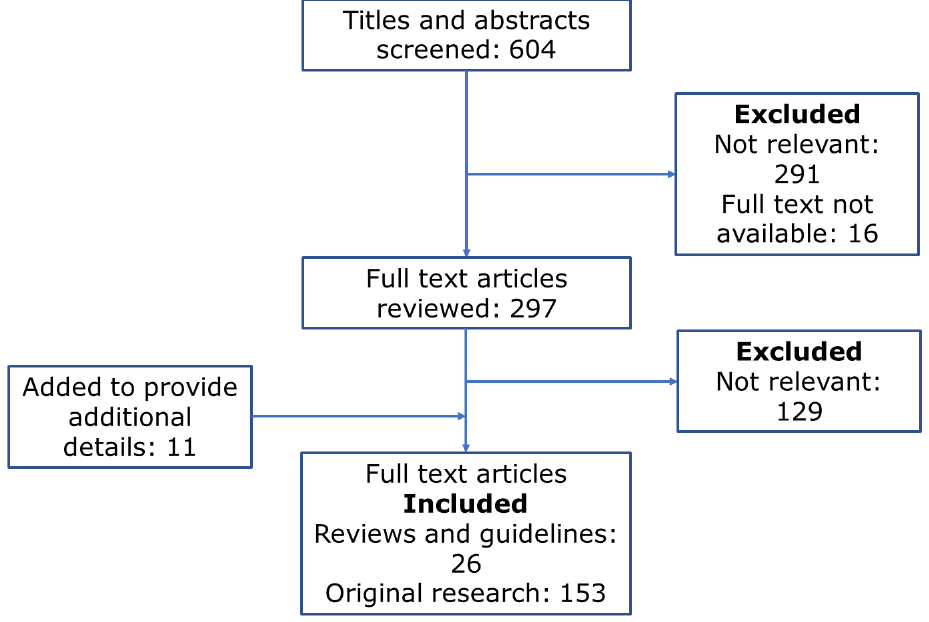
Figure 2. Literature search process.